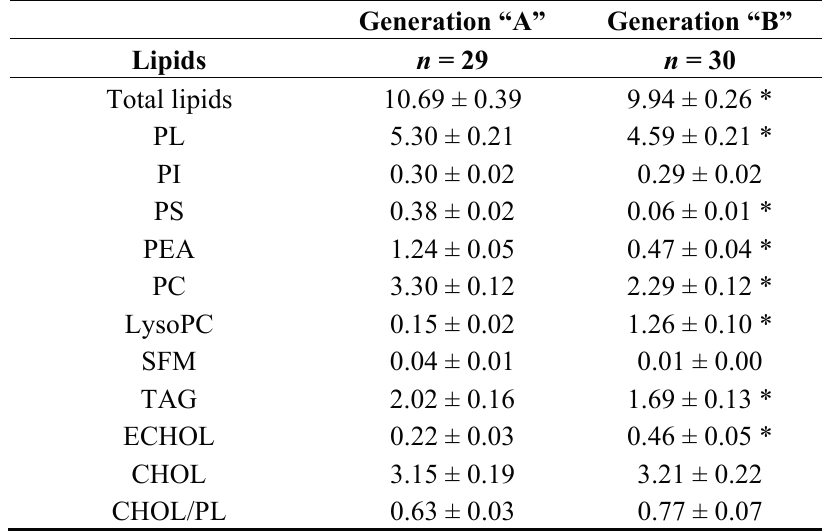
Table 2. Total lipid and lipid class content of the salmon fingerlings of two generations (% dry